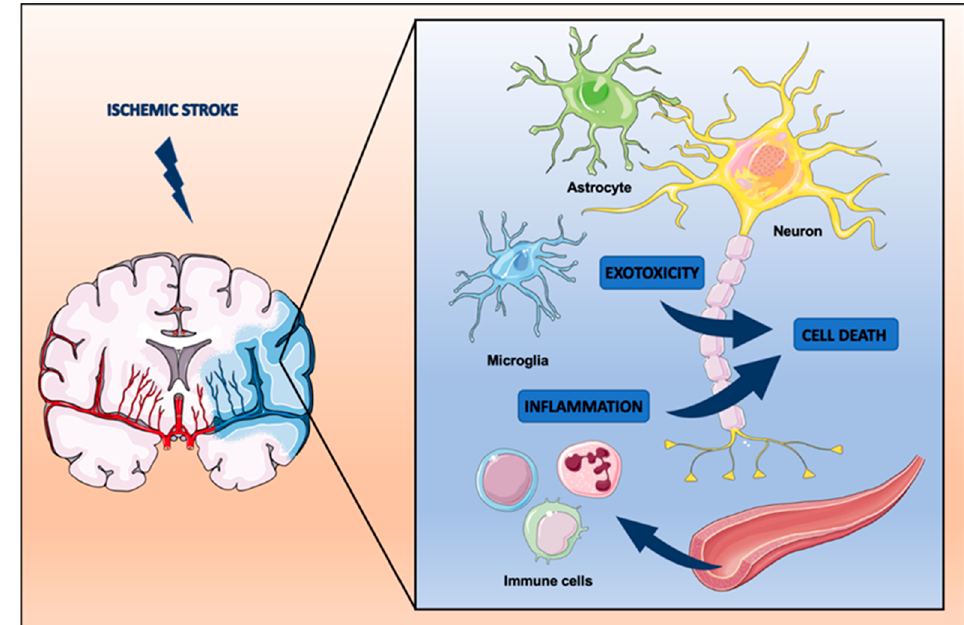
Figure 1. Pathophysiology of ischemic stroke and common targets for neuroprotection.